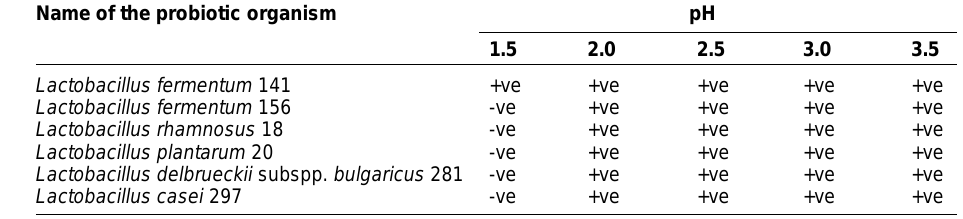
Table-1. Survivability of Lactobacillus species at different pH levels in MRS broth. Name of the probiotic organism